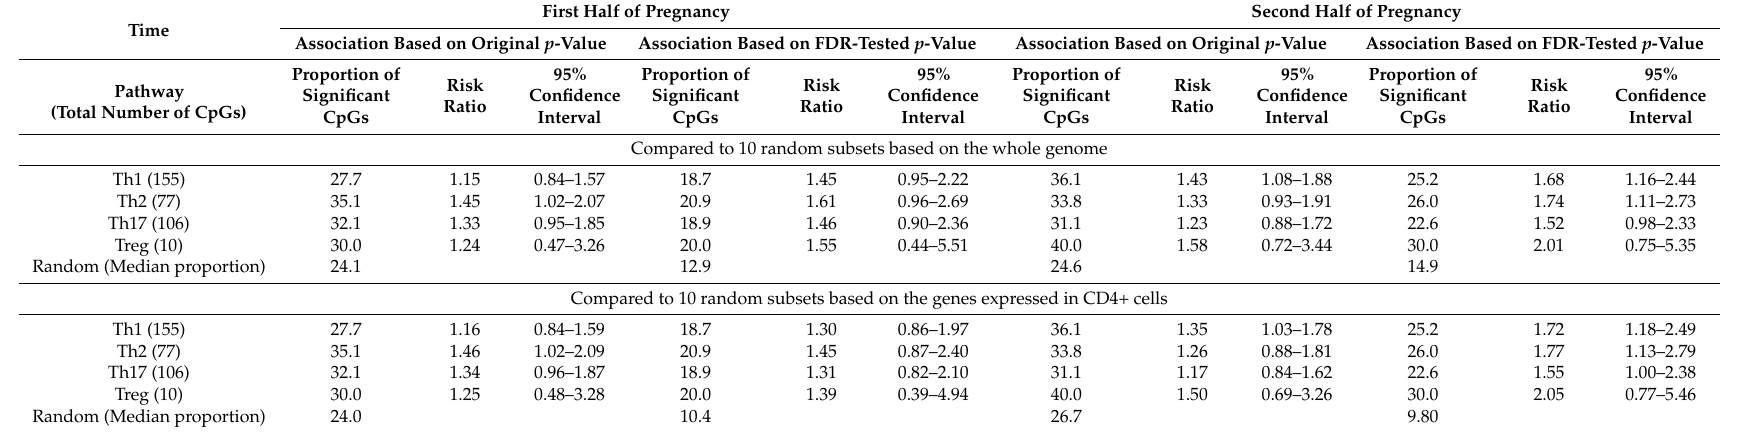
Table 6. Relative risk of significant CpG changes in immune pathways in pregnancy compared to random